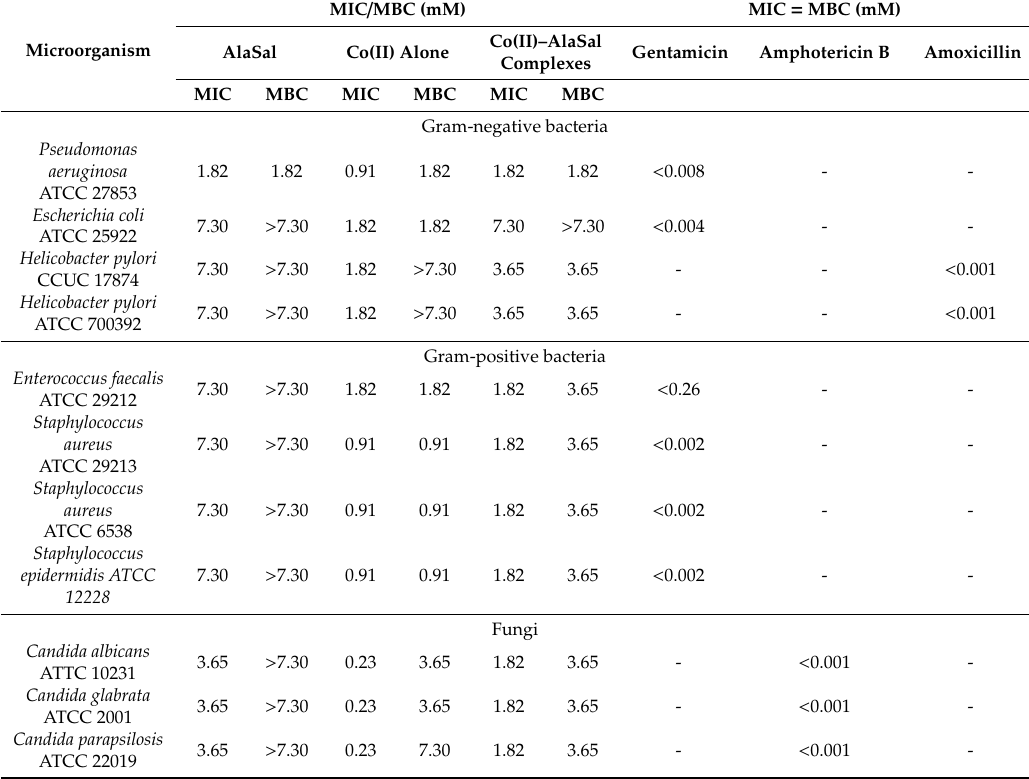
Table 2. Antimicrobial activity of tested compounds, prepared directly and stored for two weeks, shown as minimal inhibitory concentration (MIC) and minimal bactericidal concentration (MBC). Gentamicin, amoxicillin and amphotericin B used as antibacterial and antifungal reference substances, respectively; (-) not